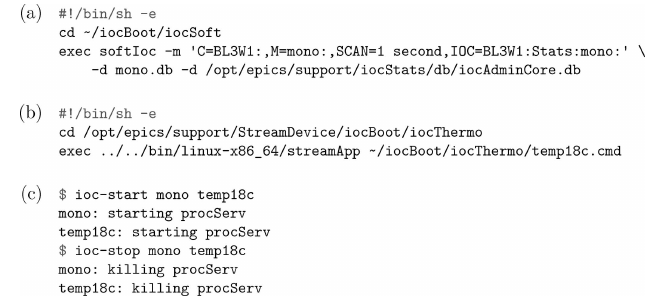
Figure 9 Run scripts in $ f HOME g = iocBoot = service in a production environ- ment for ( a ) a LabView-based monochromator gatewayed to EPICS with CA Lab ( run - mono : sh ) and ( b ) some Cryo-con 18C temperature monitors ( run - temp18c : sh ), with ( c ) example invocations of utilities that start and then stop corresponding applications.